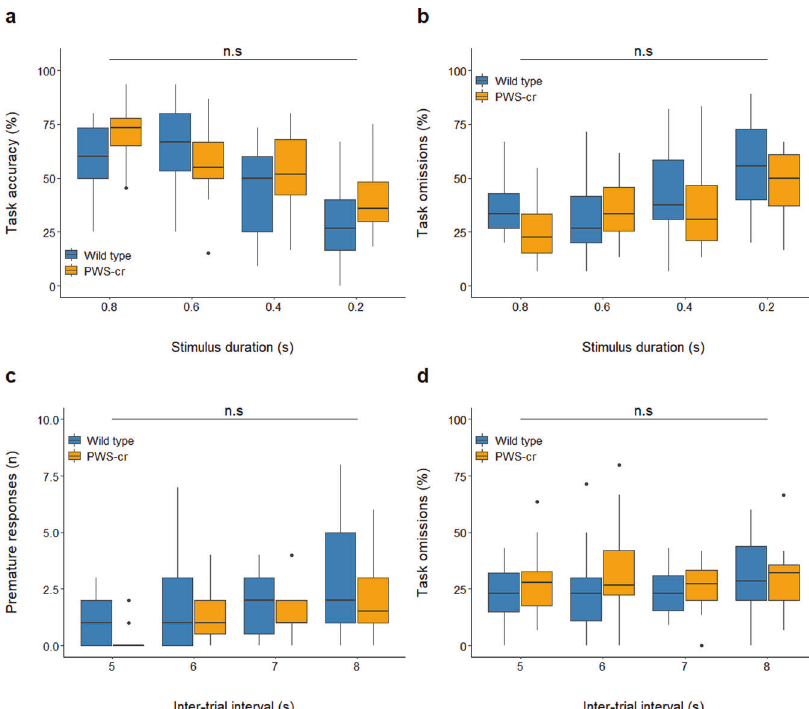
Fig. 4 Shortened stimulus duration and increased inter-trial intervals at the 5-CSRTT. Shortening the stimulus duration at the 5-CSRTT reduced performance accuracy ( p < 0.001) ( a ) and increased percentage of trial omissions ( p < 0.001) ( b ) but revealed no difference between the behaviour of PWS-cr mice ( n = 15) and their wild type littermates ( n = 21). Increasing the inter-trial intervals lead to an increase in premature responses ( p < 0.001), which was not affected by genotype (PWS-cr = 18, WT = 24) ( c ). Omissions were also not affected by genotype in this task manipulation ( d Table 1. Summary table comparing behavioural and cognitive fi ndings in the PWS-IC and PWS-cr mouse model for Prader-Willi syndrome. Behavioural domain and measures